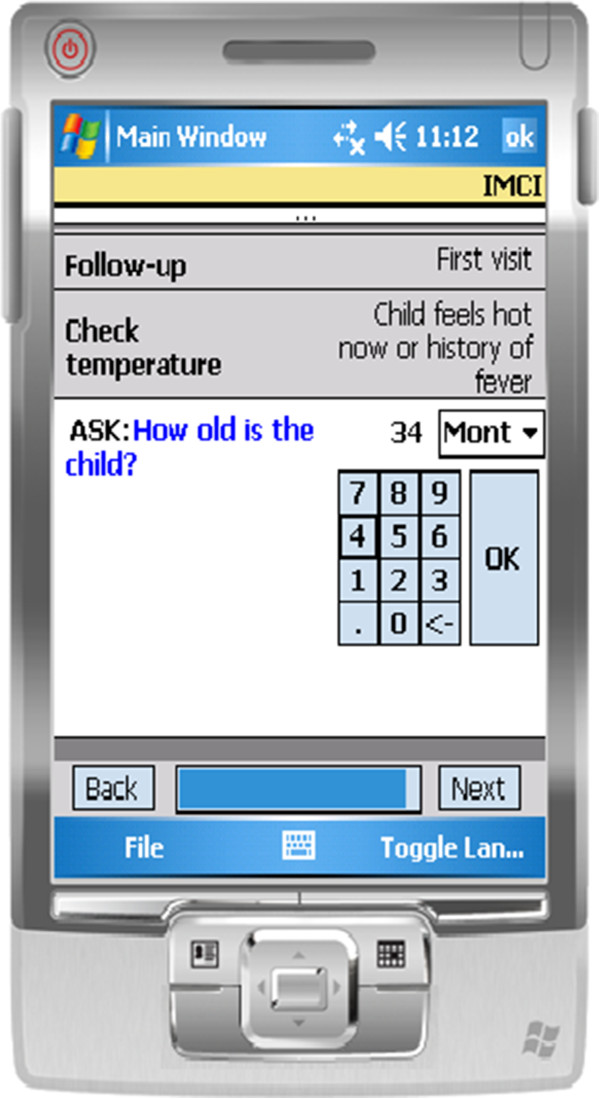
Screenshot of eIMCI.